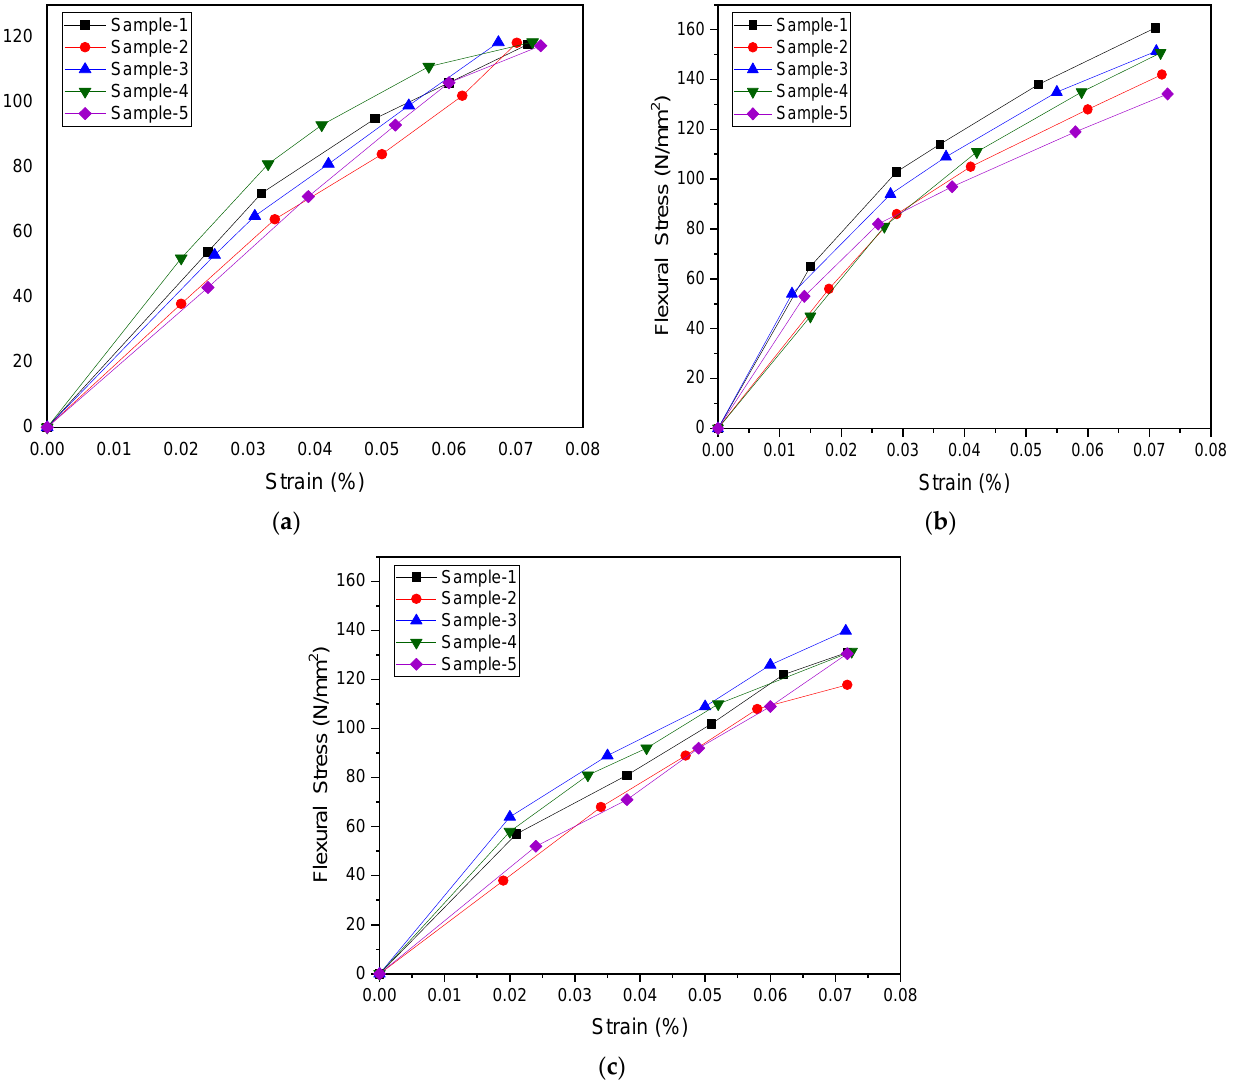
Figure 8. Flexural stress–strain curves for ( a ) 0.1, ( b ) 0.5, and ( c ) 1.0 wt.% COOH-MWCNT in PMMA.